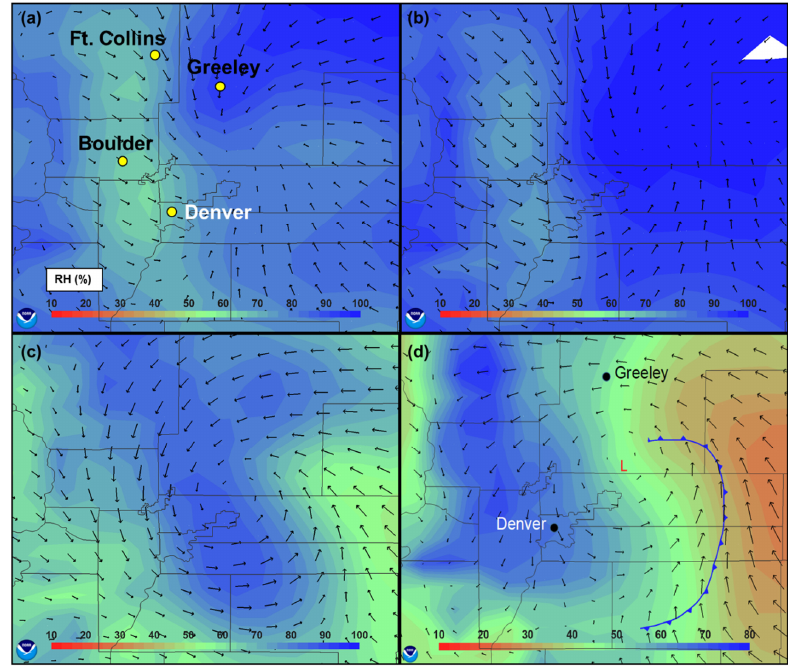
Figure 3. RAP model analysis runs at 13km resolution for the Denver Cyclone on Sunday, 27 July 2014, at (a) 10:00UTC (03:00MST), (b) 12:00UTC (05:00MST), (c) 15:00UTC (08:00MST), and (d) 18:00UTC (11:00MST). The blue line represents a convergence zone or front associated with the cyclone. Arrows show surface wind vectors, while the color scale represents surface